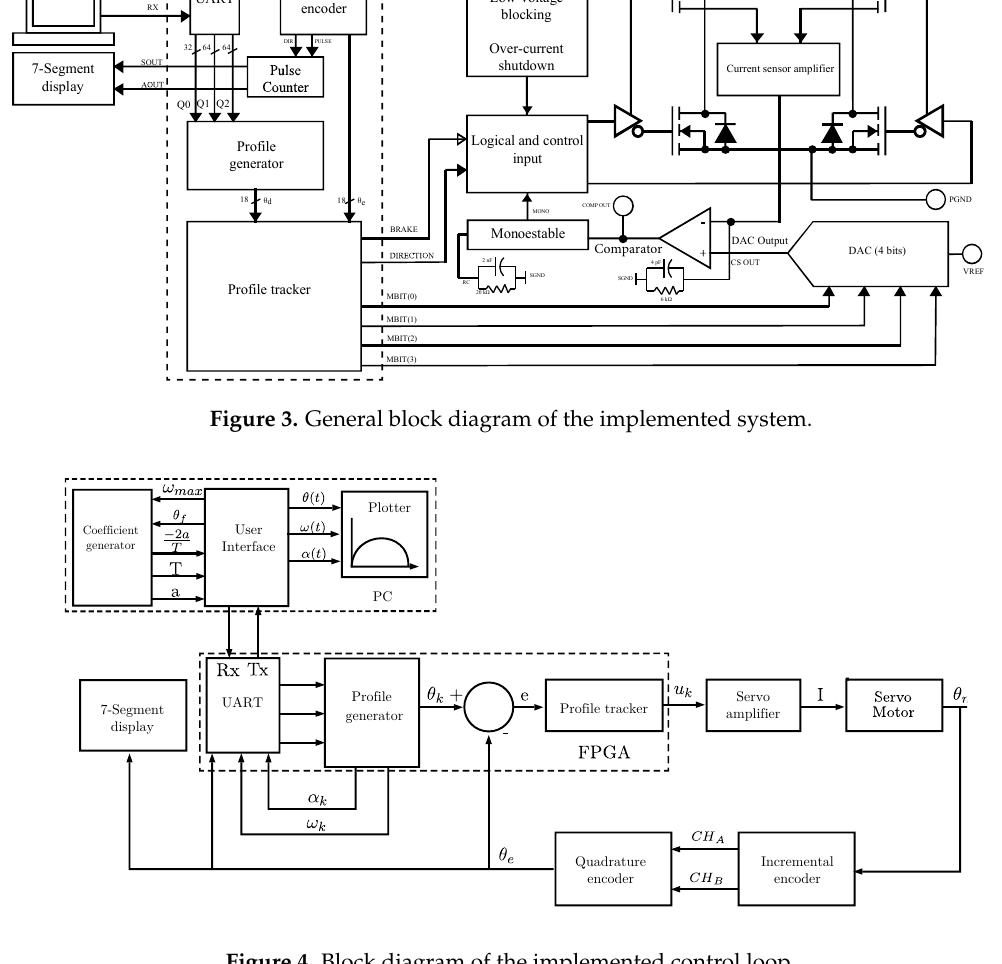
Figure 4. Block diagram of the implemented control loop. Table 5. Main characteristics of the FPGA